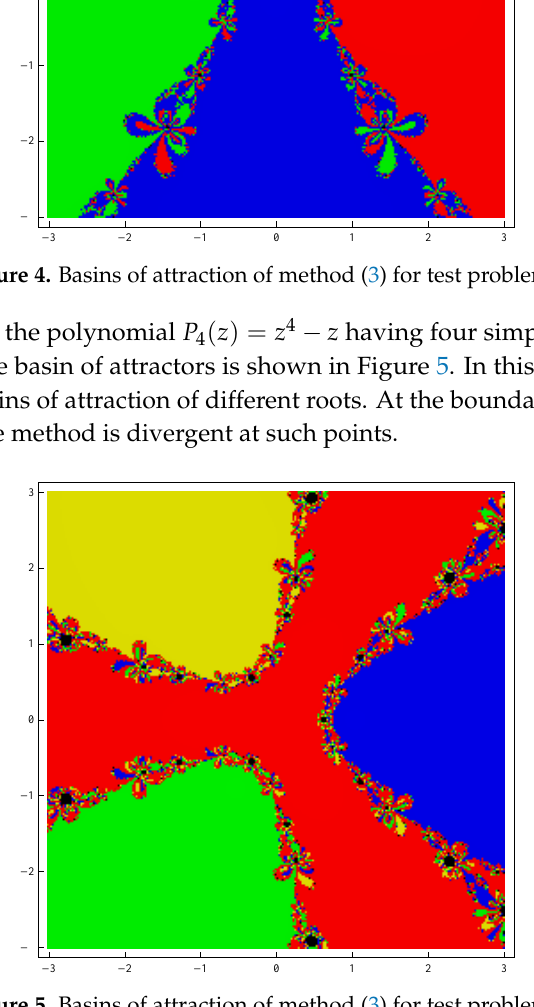
Figure 5. Basins of attraction of method (3) for test problem